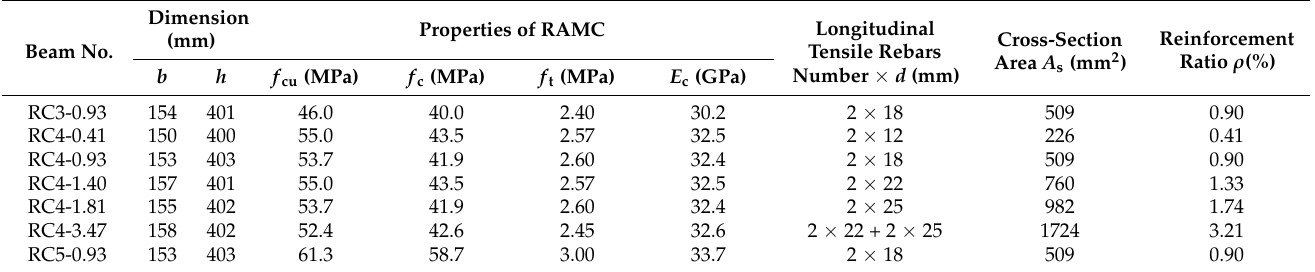
Table 3. Test results of cross section, RAMC properties and reinforcement of test beams.